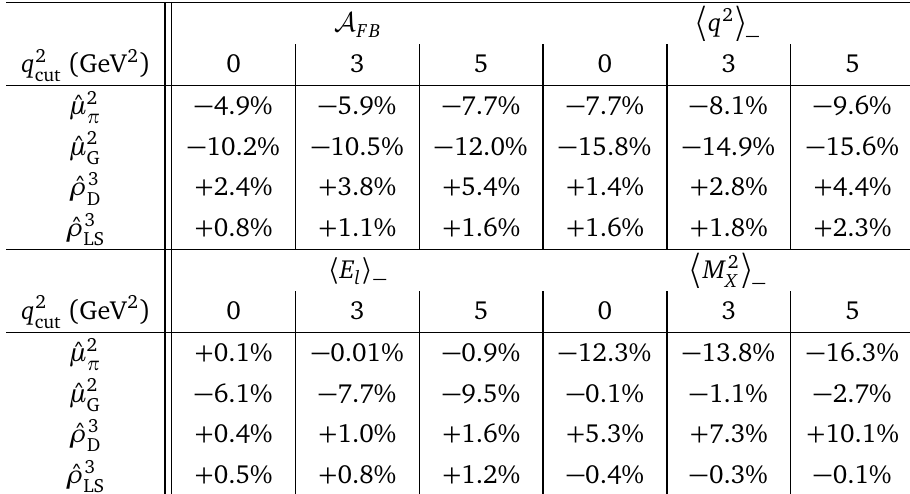
〉 − from non- O (cid:0) (cid:1) 1 / m 0 b O